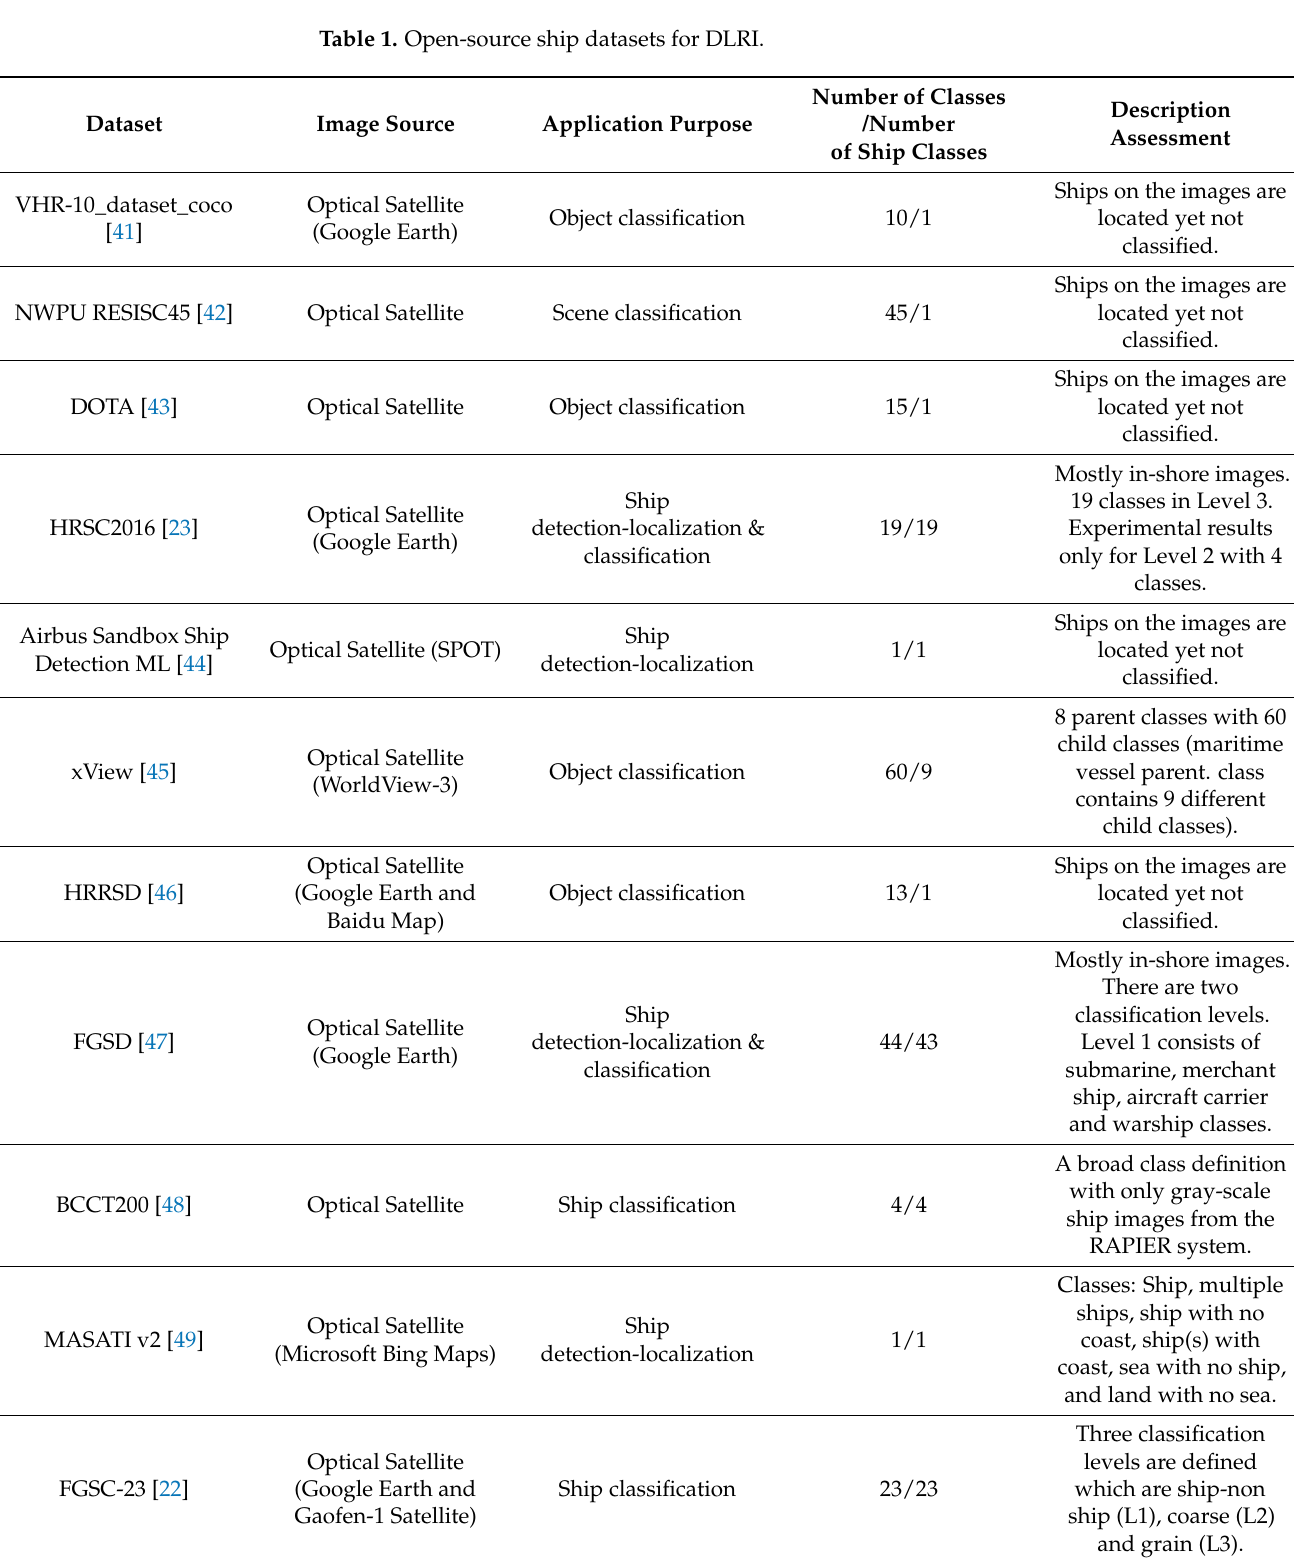
Table 1. Open-source ship datasets for